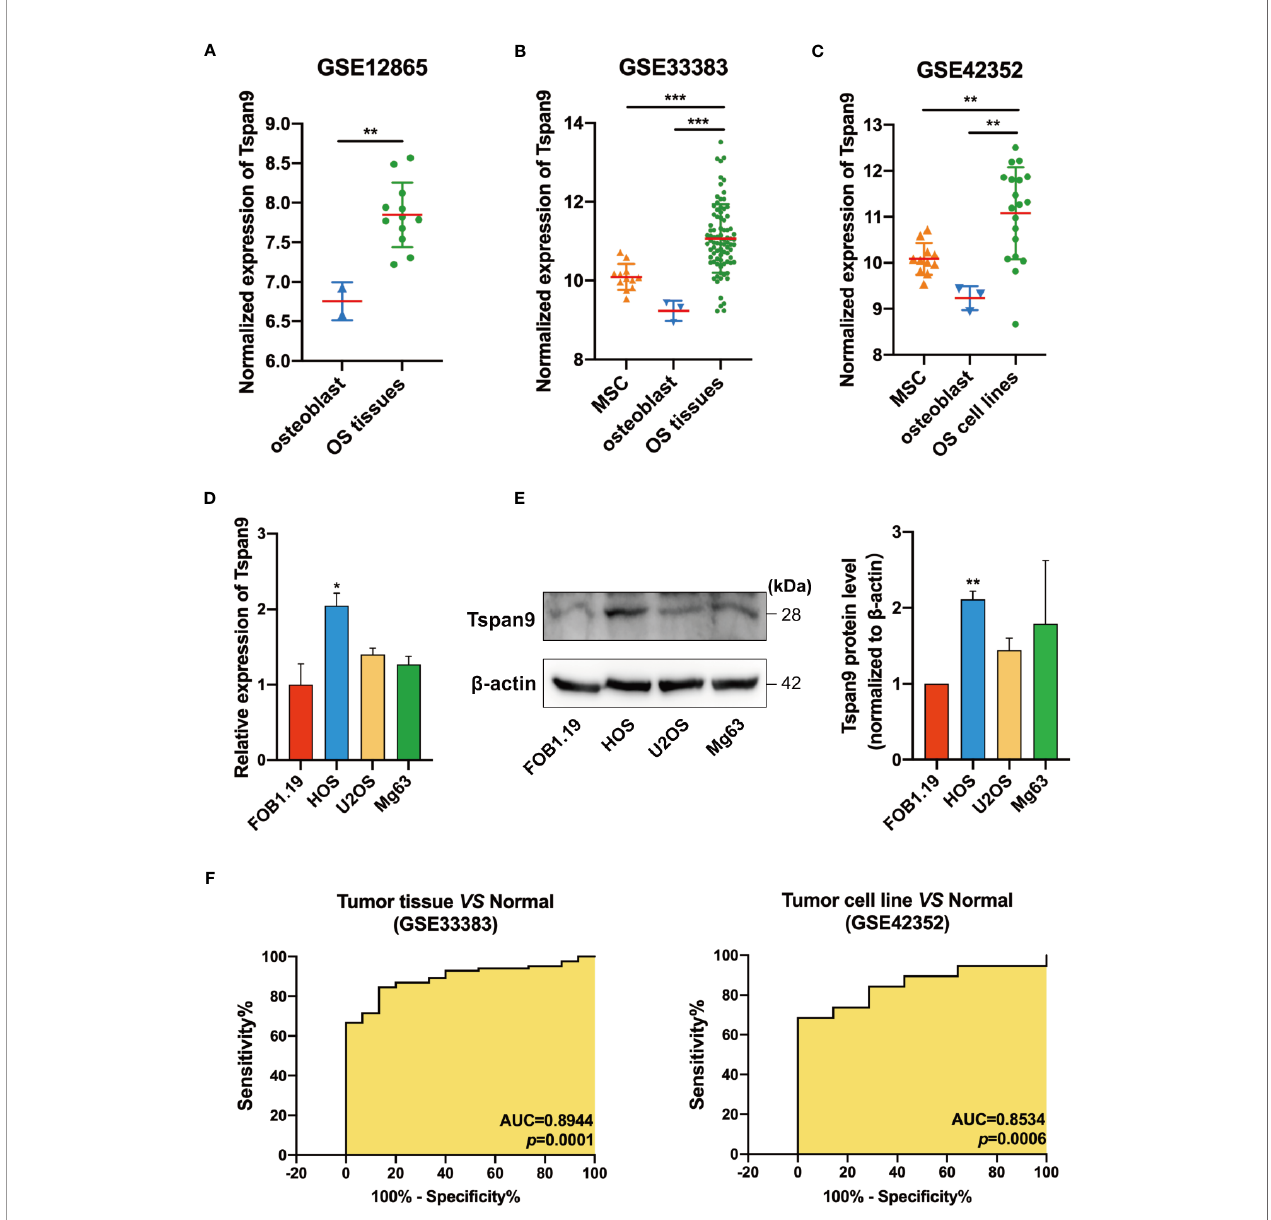
FIGURE 1 | Human OS cells and tumor tissue samples exhibit Tspan9 upregulation. (A – C) Tspan9 mRNA levels were signi fi cantly elevated in OS tumor tissues and cell lines in the GSE12865, GSE33383, and GSE42352 datasets relative to levels in normal MSCs and OBs. (D) Relative Tspan9 mRNA levels were markedly increased in HOS cells relative to control hFOB1.19 cells, whereas no changes were evident in U2OS or Mg63 cells as assessed via qRT-PCR. GAPDH served as a normalization control. (E) Western blotting results revealed that Tspan9 protein expression in HOS but not U2OS and Mg63 was signi fi cantly higher compared to hFOB1.19 cells. b -actin was used as a loading control and for normalization. Data are means ± SD from two independent experiments. (F) ROC curves and AUC values were determined using the GSE33383 and GSE42352 datasets. * P < 0.05; ** P < 0.01; *** P < 0.001; Student ’ s t-test. Tspan9, Tetraspanin-9; MSC, mesenchymal stem cell; OB: osteoblast; OS: osteosarcoma; GEO: Gene Expression Omnibus; qRT-PCR, quantitative reverse -transcription polymerase chain reaction; GAPDH, glyceraldehyde-3- phosphate dehydrogenase; SD, standard deviation; ROC, receiver operating characteristic; AUC, area under the